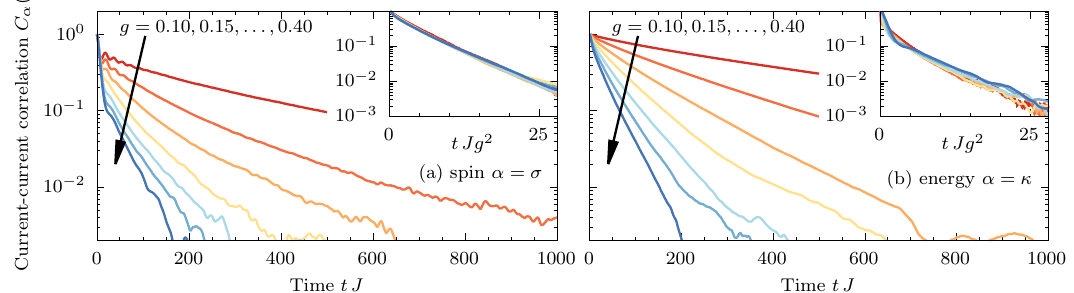
Figure 1: Normalized correlation functions C α ( t ) for (a) spin current j σ and (b) = 4 sector, calculated for L = 28 and ∆ = 0.5. energy current j κ , respectively, in S z tot Insets: the same as in main panels but with the time t rescaled by the square of the perturbation strength g 2 .